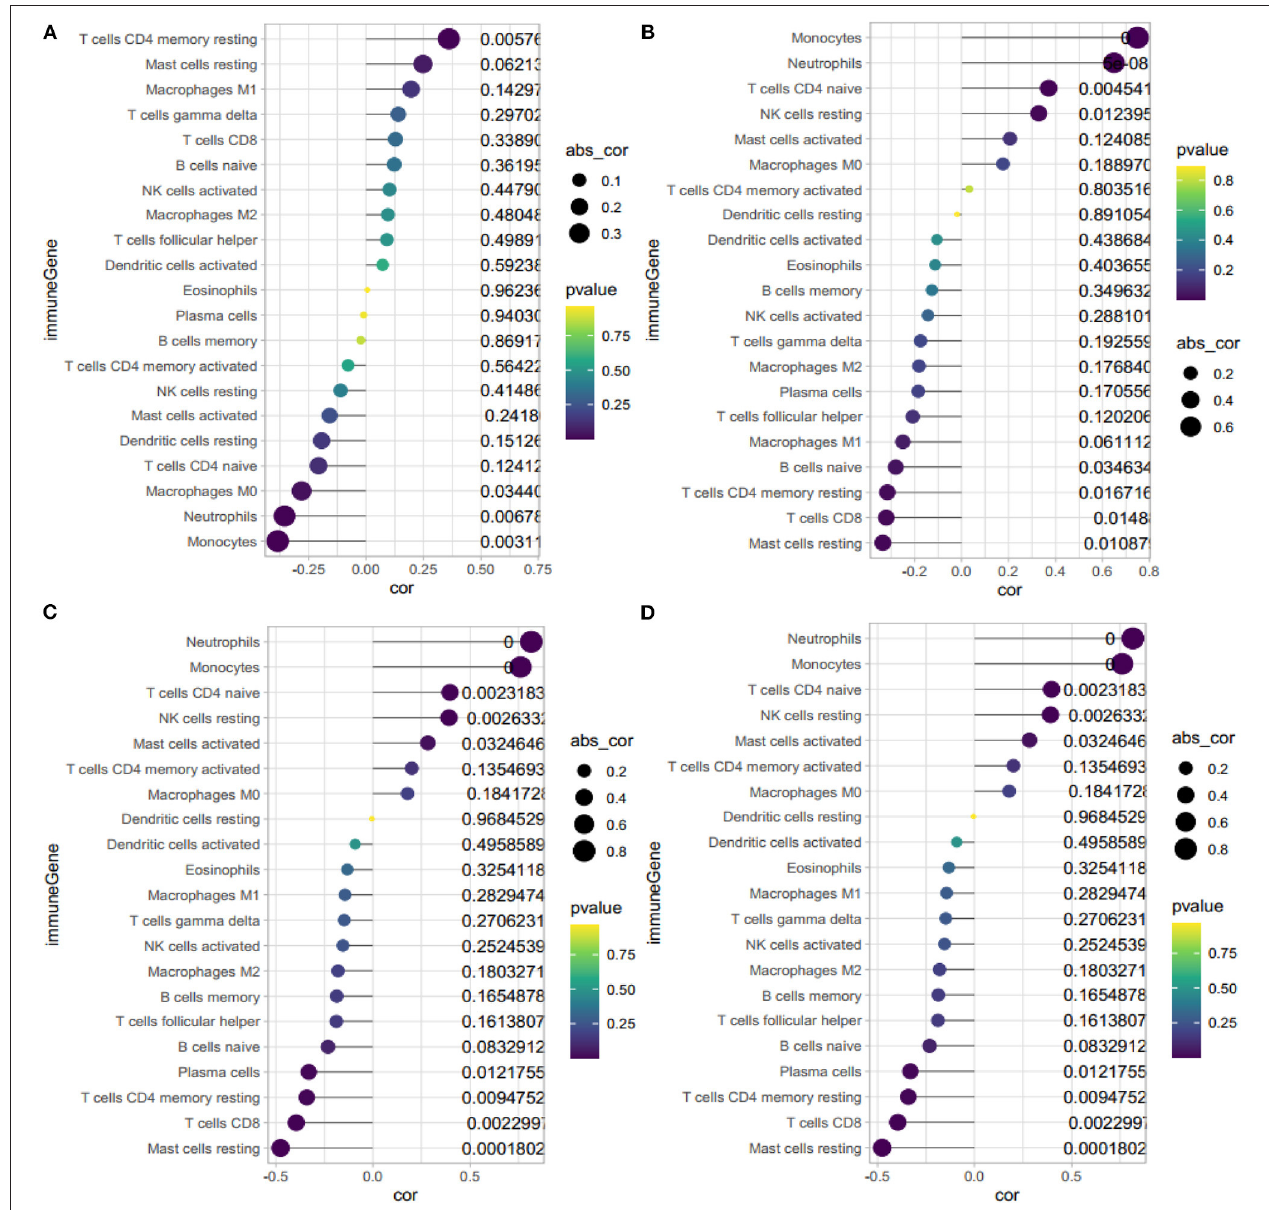
FIGURE 8 | Correlation between HBB , RNASE2 , S100A9 , IL1R2 and immune cells. (A) Correlation between HBB and immune cells. (B) Correlation between RNASE2 and immune cells. (C) Correlation between S100A9 and immune cells. (D) Correlation between IL1R2 and immune cells. The size of the dots represents the strength of correlation between gene biomarkers and immune cells. The color of the dots represents the P